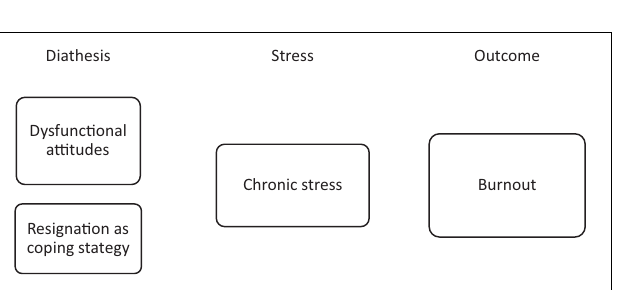
FIGURE 1 | Sport-specific diathesis stress model for depression.